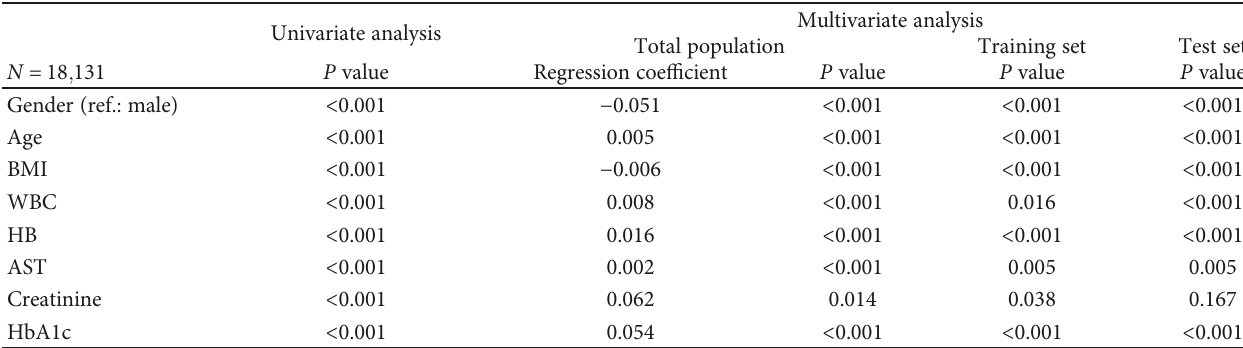
Table 2: Univariate and multivariate analyses of log-transformed serum CEA.